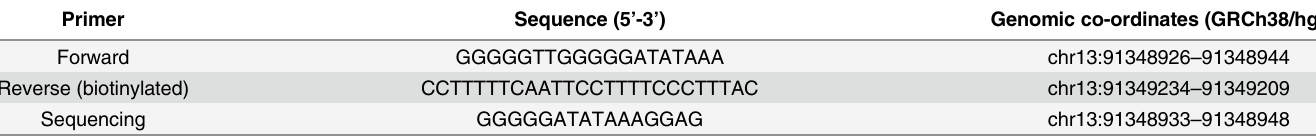
Table 2. Primers used for